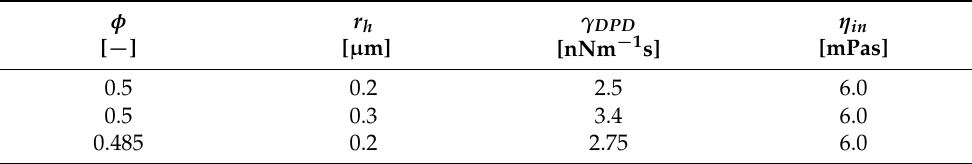
Table 7. Parameters of the inner particle suspension for RBC that result in appropriate effective viscosity η in